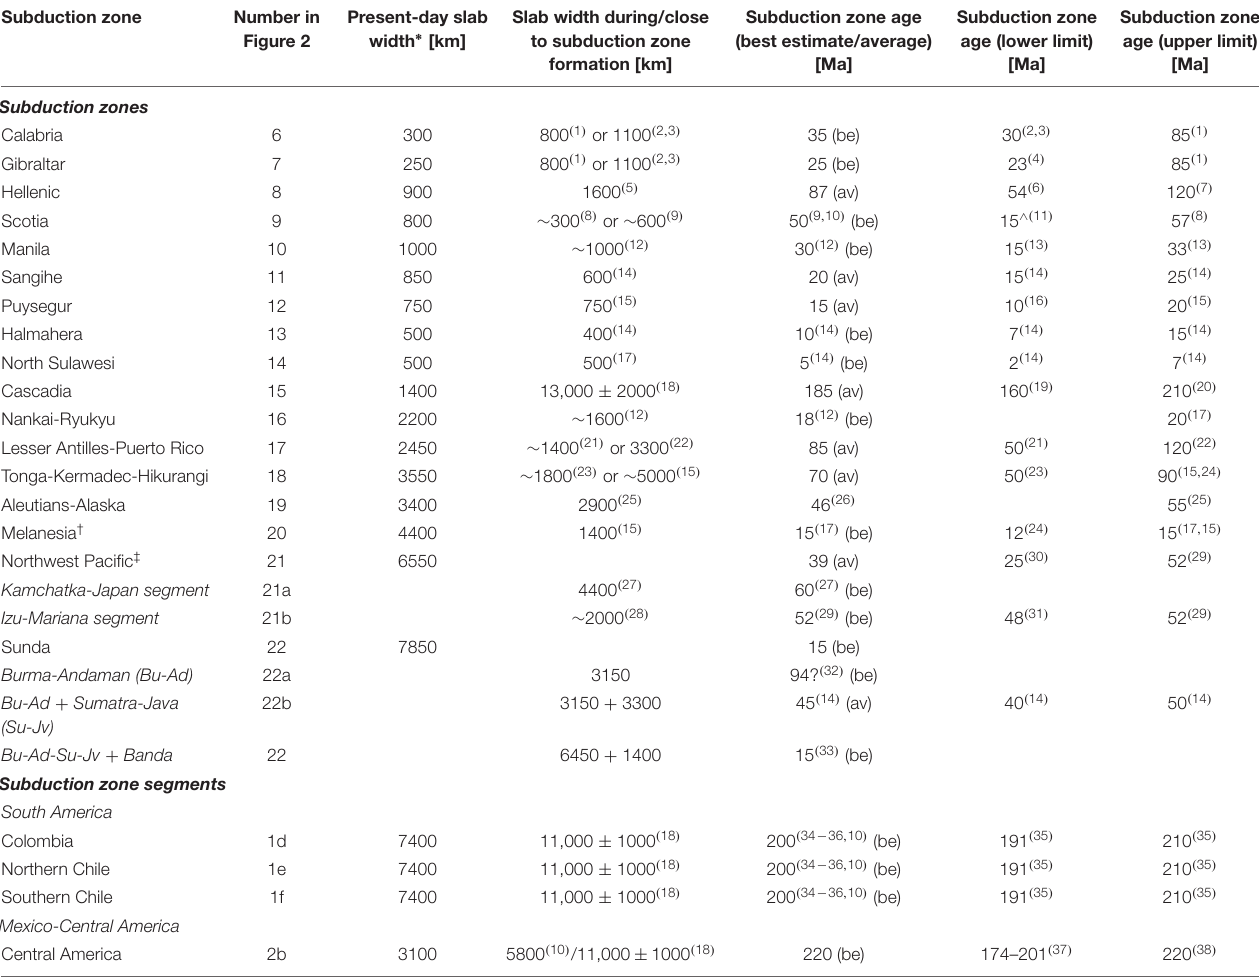
TABLE 2 | Active subduction zones and active subduction zone segments without a flat slab. Subduction